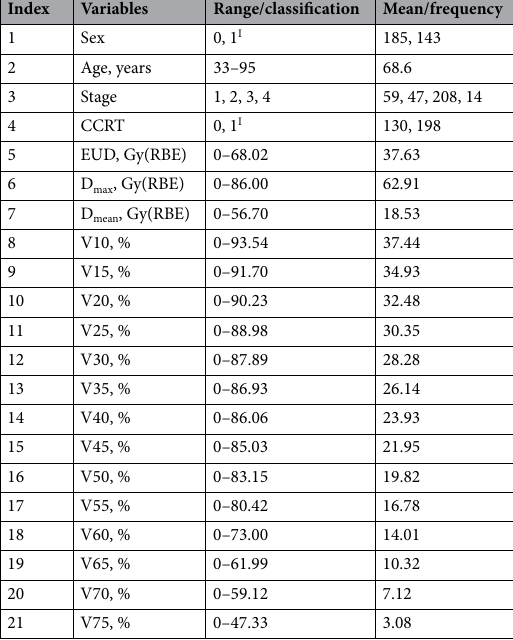
Table 1. Candidate clinical variables and EUD values of the data set. I 0 = male, 1 = female. II 0 = no, 1 = yes. CCRT concurrent chemotherapy, EUD equivalent uniform dose, RBE relative biological effectiveness, D max maximum dose, D mean mean dose, V x percentage volume receiving dose higher than x Gy